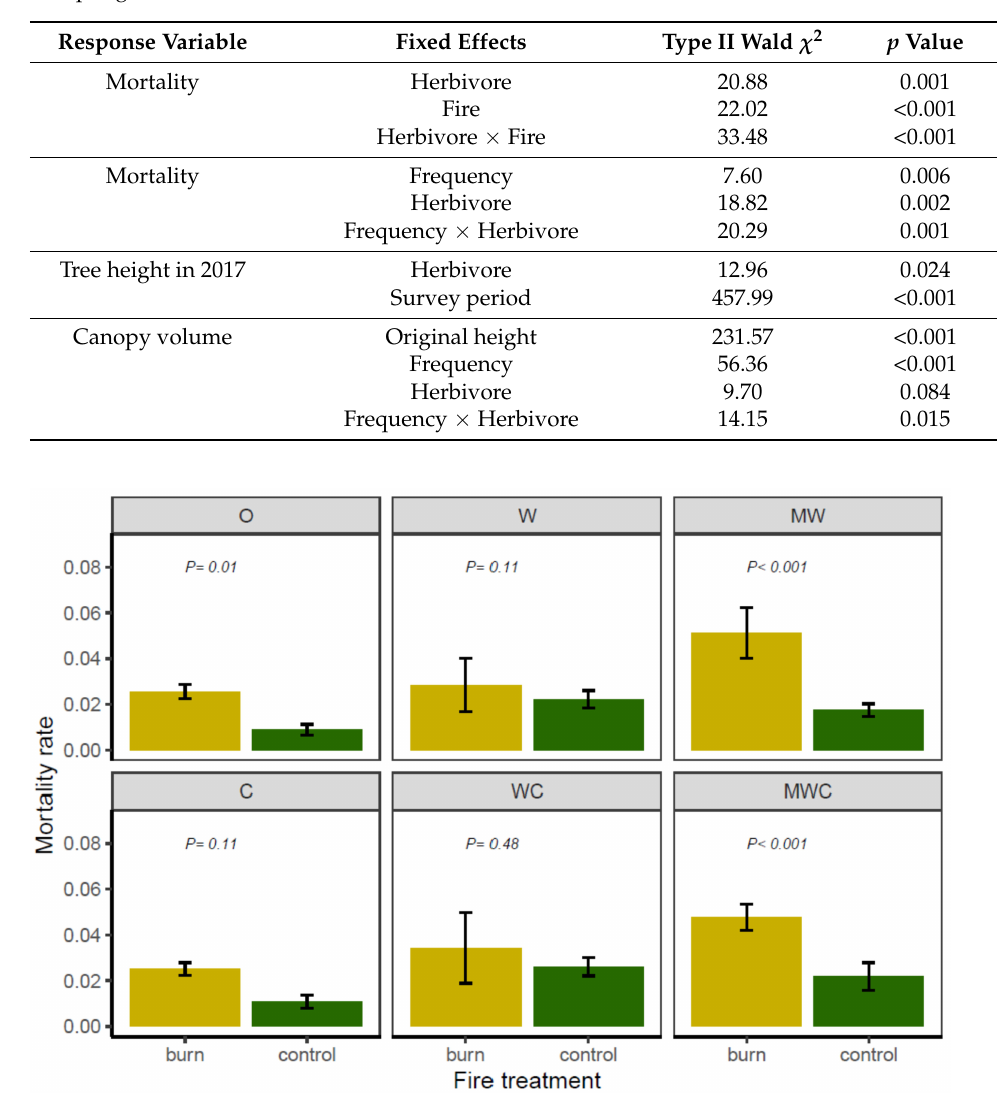
Table 2. Analysis of deviance table (Type II Wald Chi-square tests) of generalized linear mixed models (GLMMs) testing the effects of various fixed effects on tree mortality, tree height, and canopy volume of sapling.